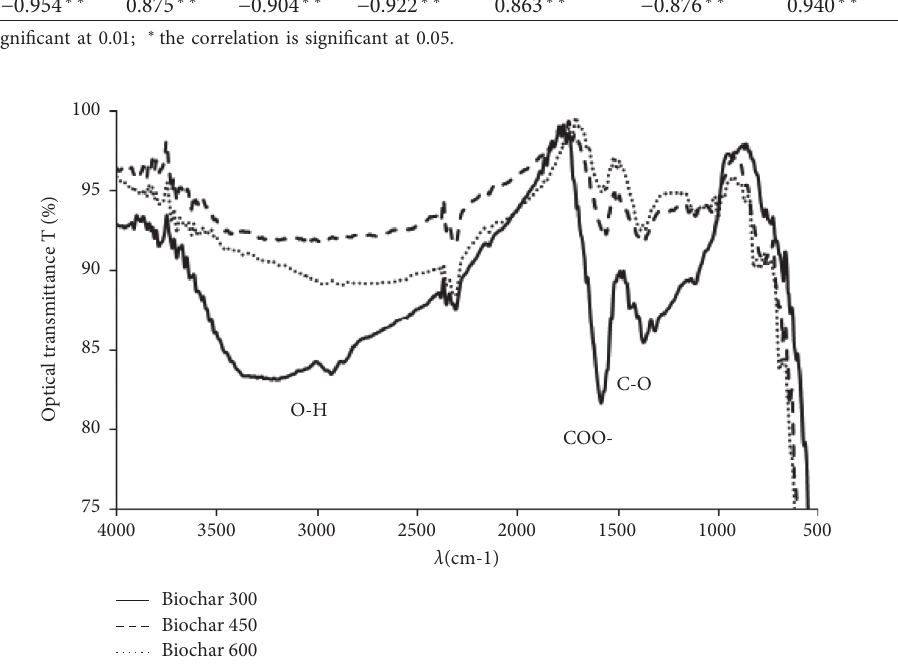
Figure 1: Biochar’s FT-IR spectra at 300, 450, and 600 °